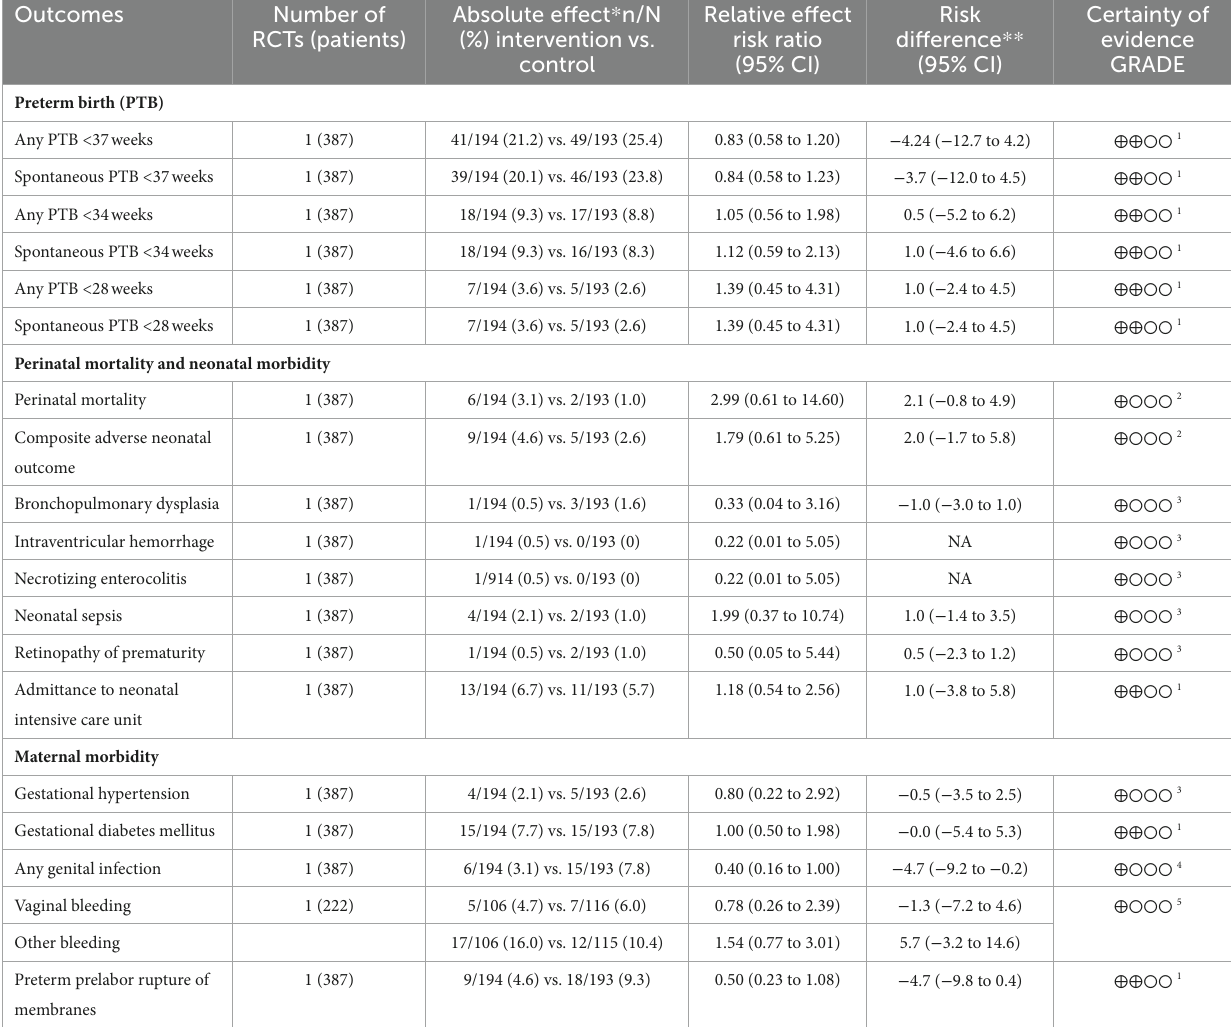
TABLE 5 Summary of findings for main outcomes (based on trials with low risk of bias): Acetylsalicylic acid (ASA) vs placebo in women with a singleton pregnancy and the risk factor previous spontaneous preterm